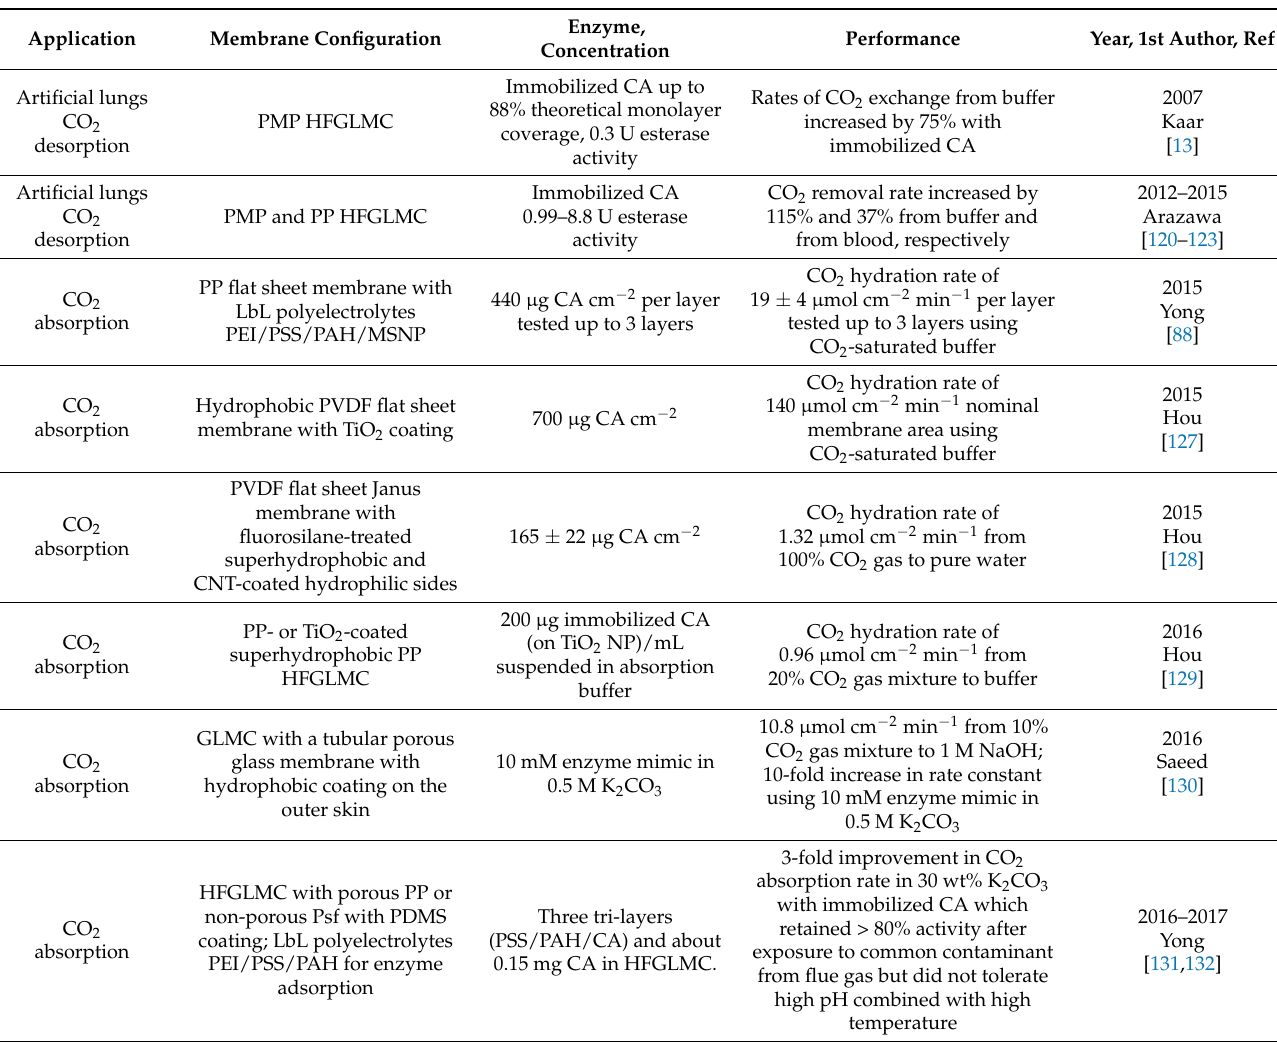
Table 3. Gas liquid membrane contactor with carbonic anhydrase for CO 2 absorption and desorption. Enzyme, Application Membrane Configuration Concentration